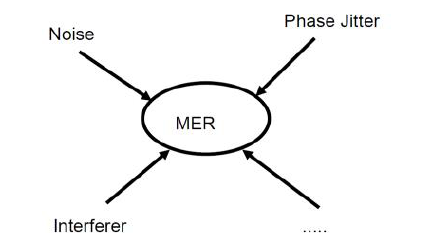
Figure 11. The total impact of interference in the transmission system.